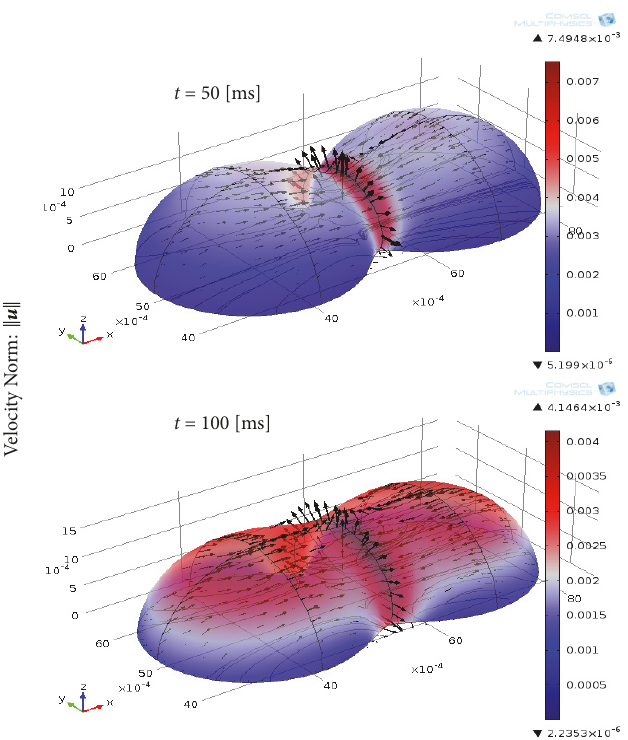
Figure 10: Three-dimensional plots of the velocity norm ‖ u ‖ of two interacting droplets of the same radius 𝑅 1 = 𝑅 2 at times 𝑡 = 100 , 190